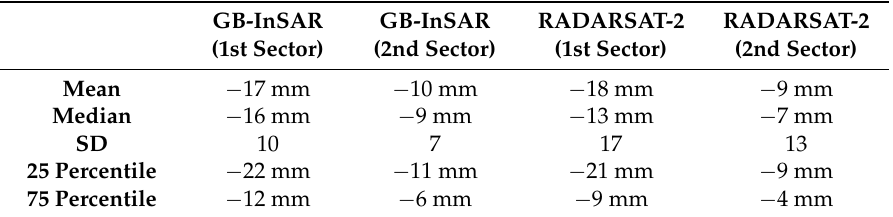
Table 4. Basic statistic parameters of the analyzed datasets (GB-InSAR data in the 1st and 2nd sectors and RADARSAT-2 data in the 1st and 2nd sectors).